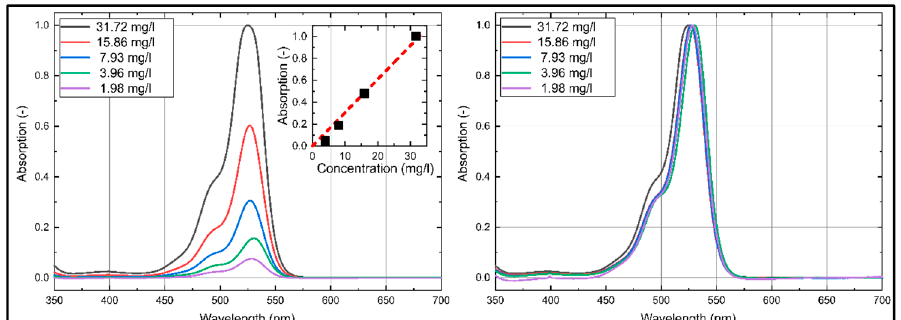
Figure 3. Absorption spectra ( left : normalized to maximum intensity of 31.724 mg/L; right : normalized to the respective maximum intensity) of Eosin-Y dissolved in ethanol, inserted diagram show linearity ( R 2 = 0.981) of the integral laser-induced fluorescence (LIF)-signal for various dye concentrations; 293 K, 0.1 MPa.